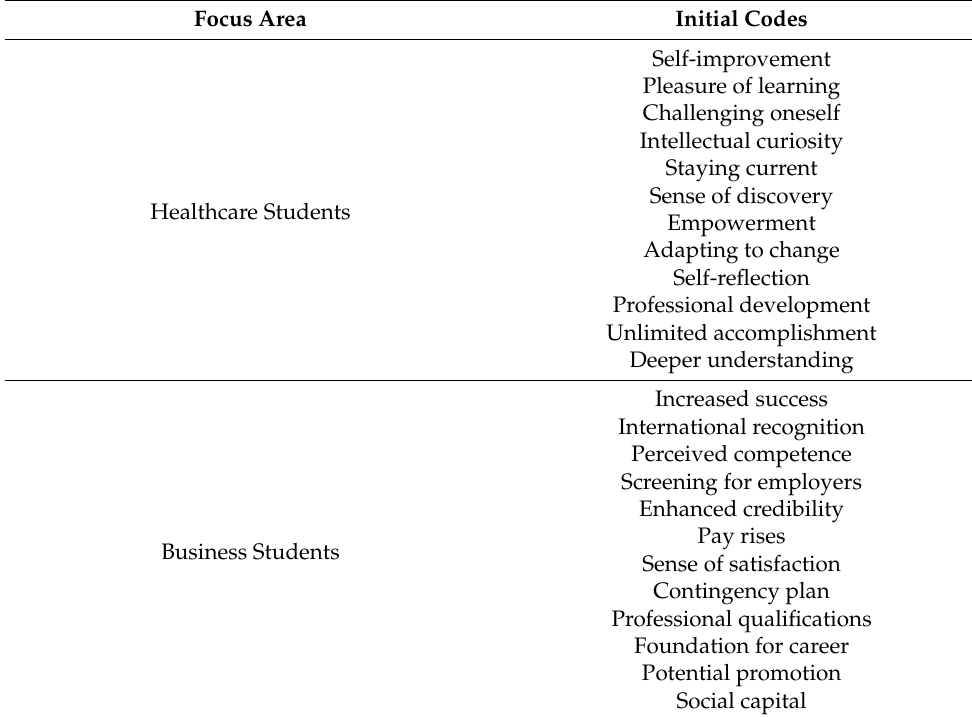
Table 2. Generating initial codes (examples).